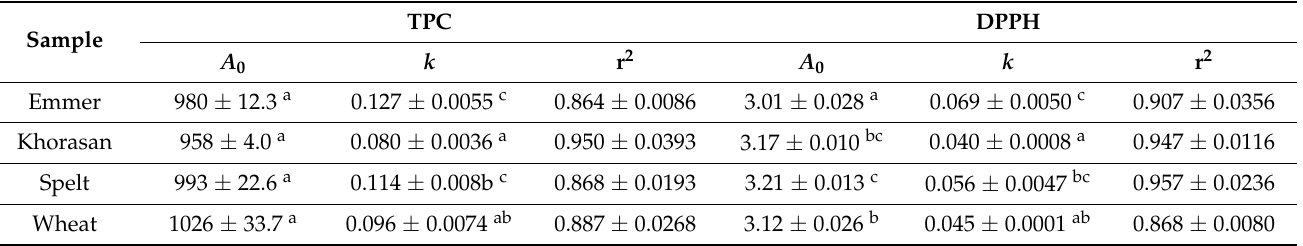
Table 3. Parameters of the first-order kinetic model of total phenolic content and antioxidant capacity change during 6 h of sourdough fermentation ( A 0 —the initial value of phenolic content or antioxidant capacity, k —the rate